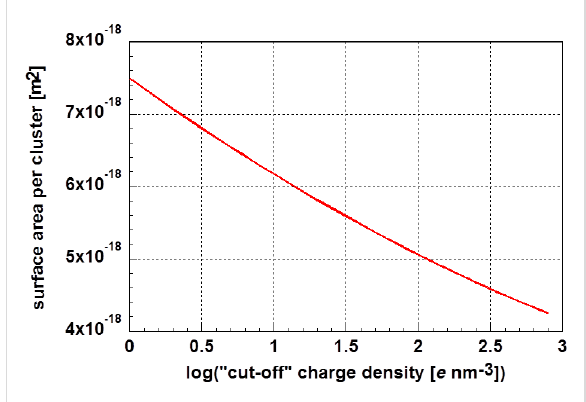
Figure 7: Surface area per Au 55 cluster in the glassy phase as a func- tion of the “cut-off” charge density.